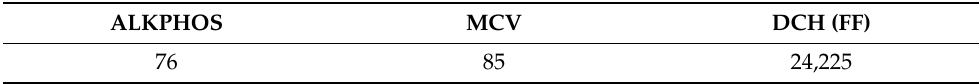
Table 4. The best individual found in case 1 for the dataset [15].